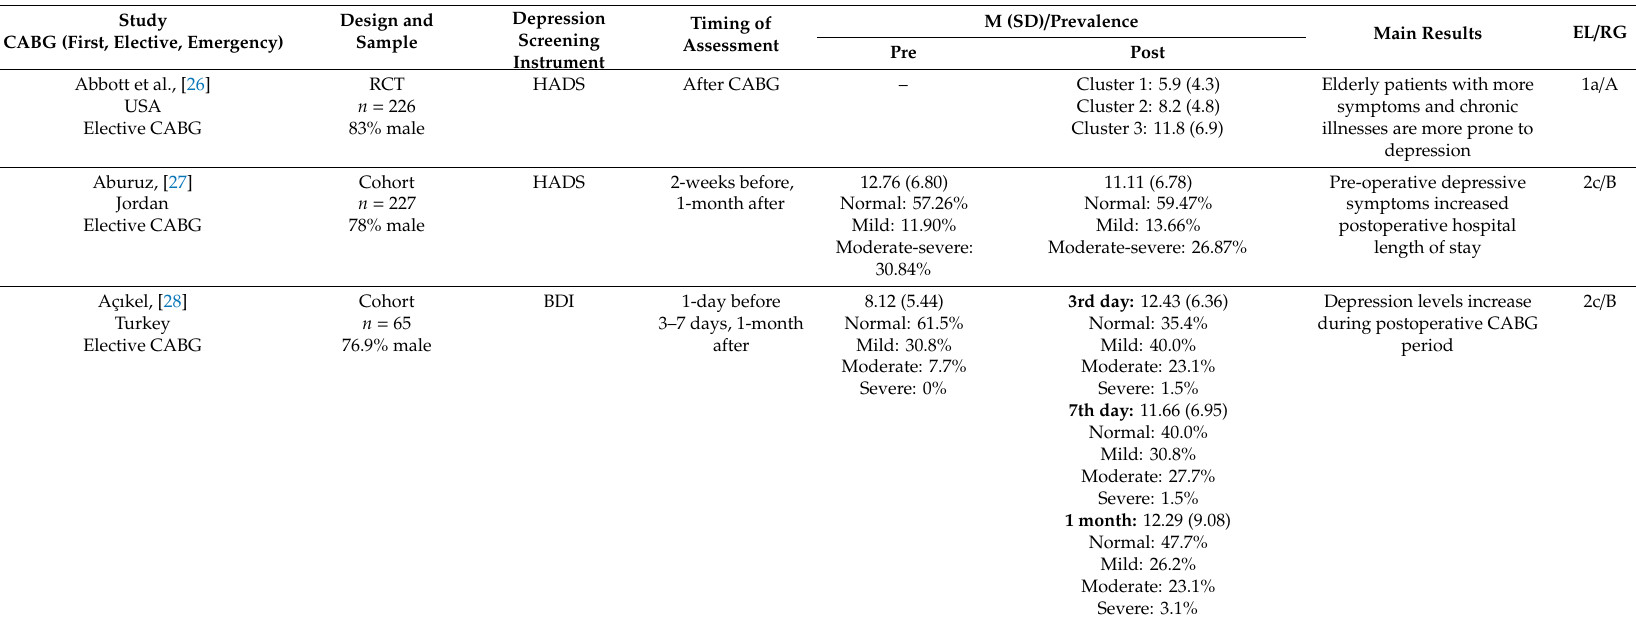
Table 1. Studies reporting prevalence and levels of coronary artery bypass graft surgery (CABG)